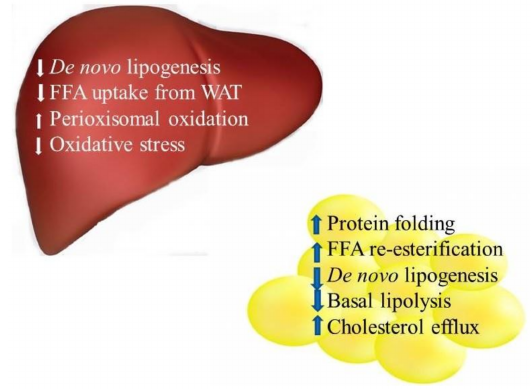
Figure 1. Suggested mechanisms of action of purple potatoes and purple carrots on Metabolic Syndrome pathologies in liver and adipose tissue. FFA: free fatty acids, WAT: white adipose